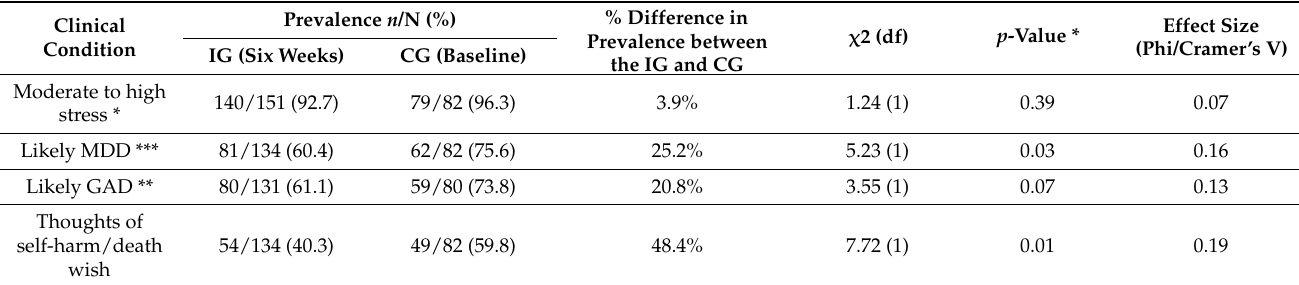
Table 6. Prevalence of clinically meaningful psychological problems in the IG (sixth week) and CG (baseline).